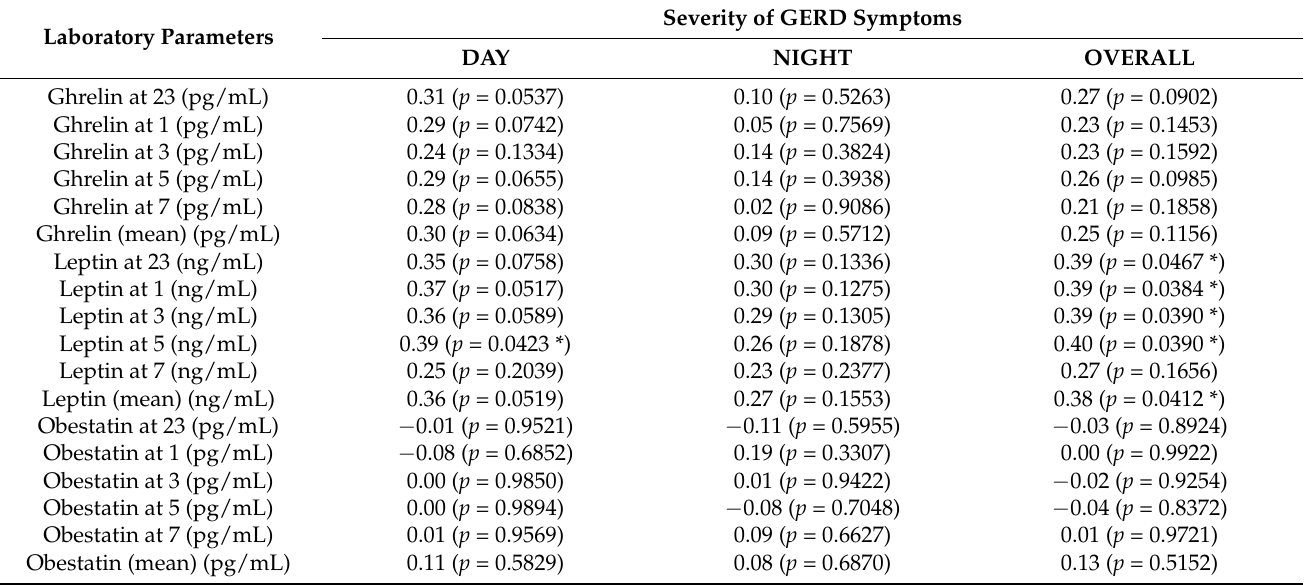
Table 7. Correlations between ghrelin, leptin, and obestatin levels and the severity of GERD symptoms—group diagnosed with GERD (statistically significant correlations, where p < 0.05, are marked using